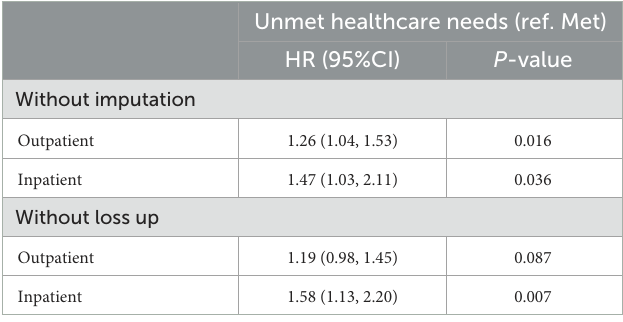
TABLE 4 Sensitivity analysis ∗ .